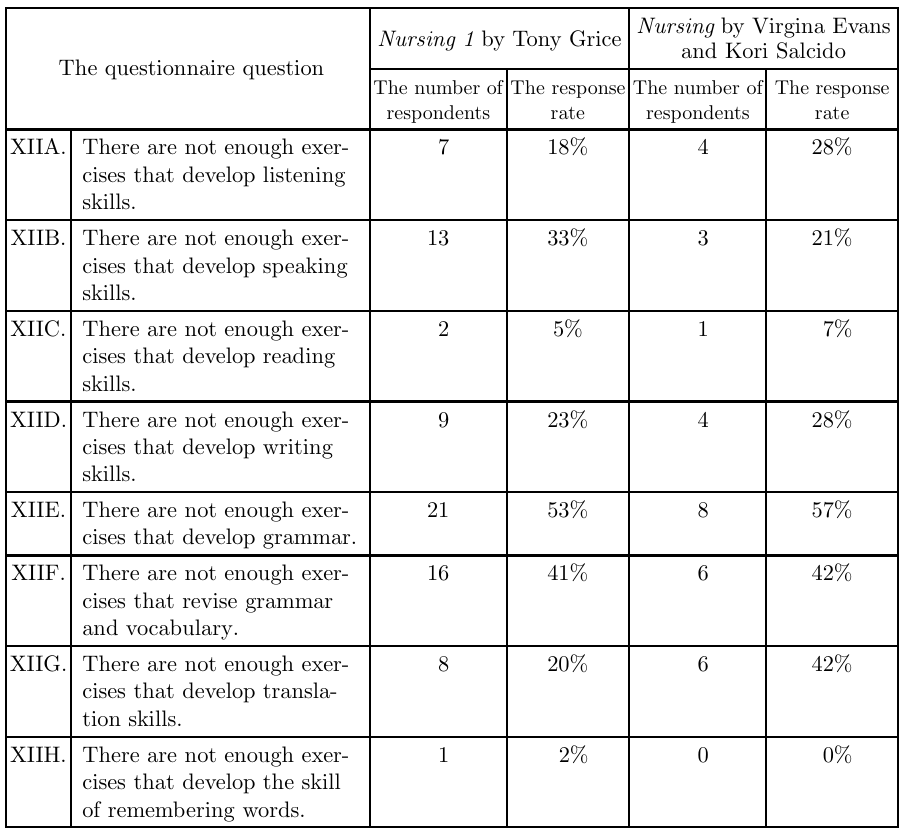
Findings of the 2014 questionnaire on the deficiencies of two EMP coursebooks: author’s own